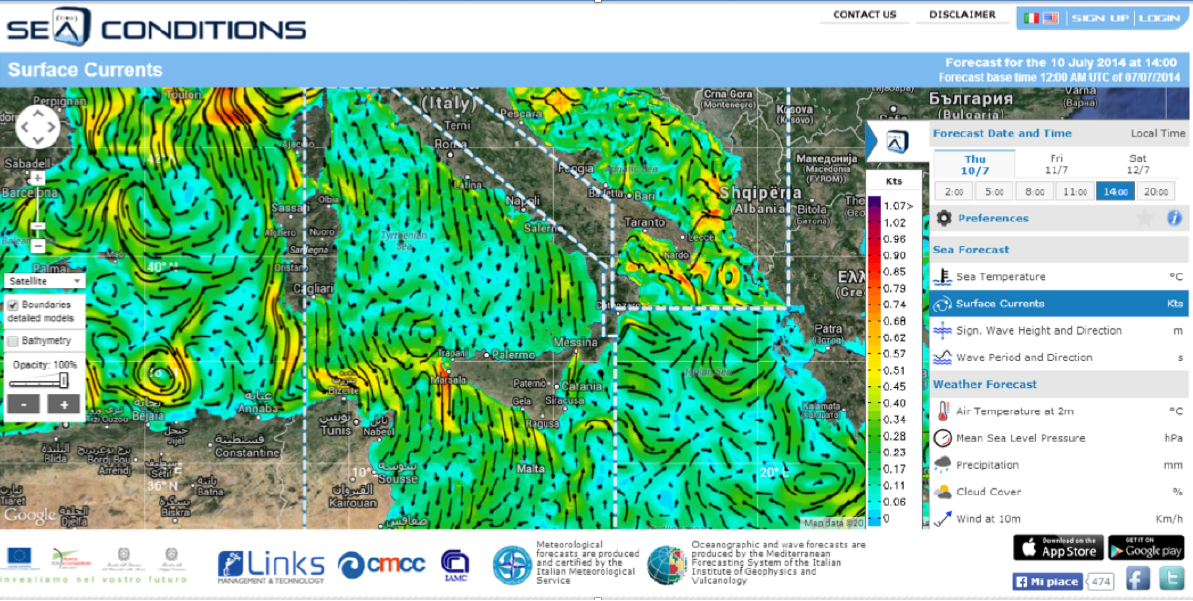
Figure 6. SeaConditions web application – example of ocean surface currents with the subregional products highlighted by a dashed white